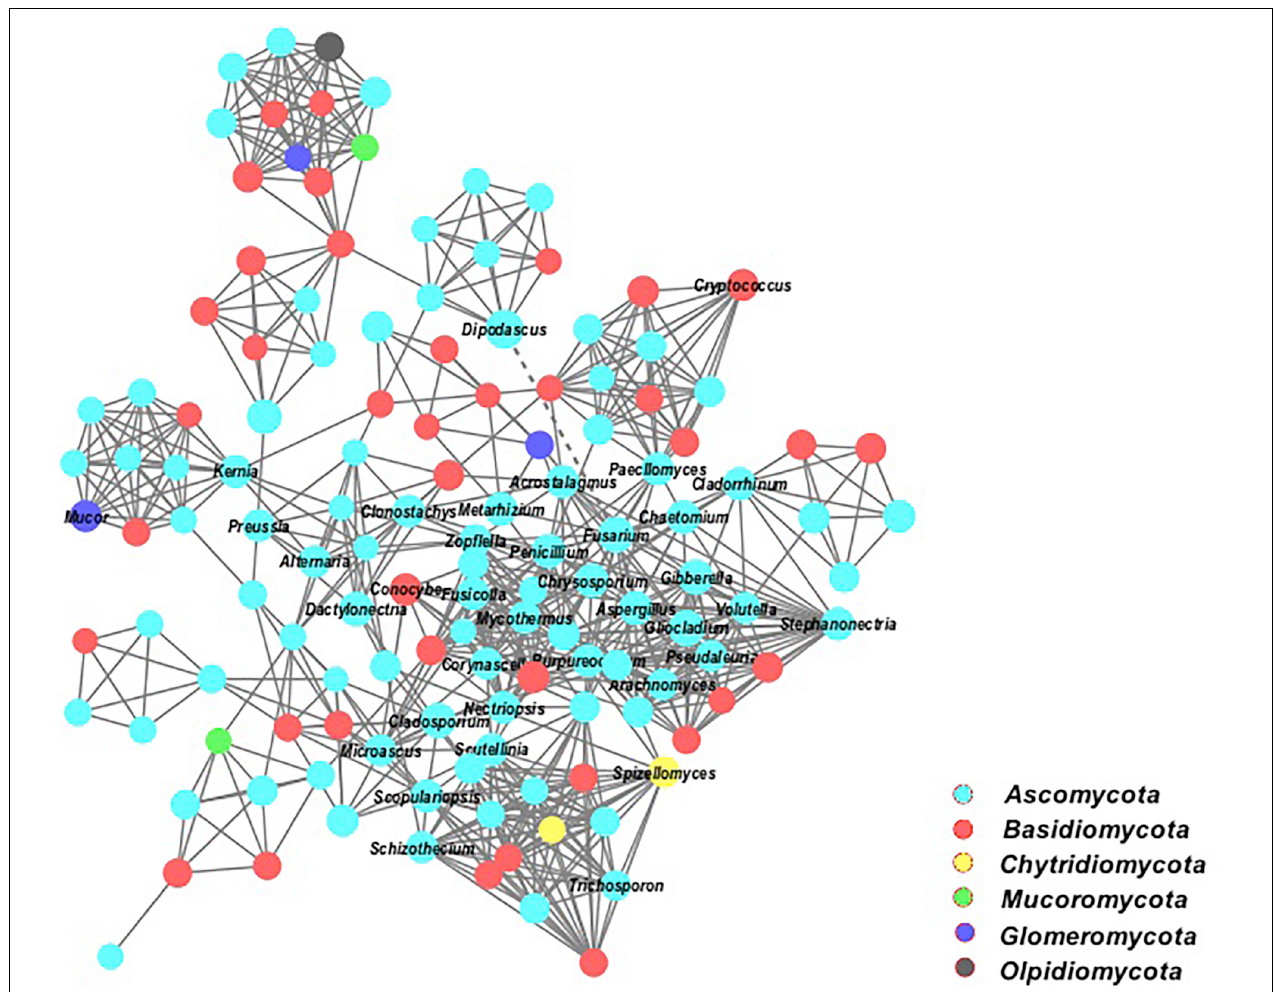
FIGURE 8 | Co-occurrence network of the dominant fungal communities at genus level based on OTUs profiles. Each connection shows a spearman’s correlations ( p < 0.05). Smooth straight lines connecting nodes represent positive (+), and dotted lines show negative ( − ) co-occurrence